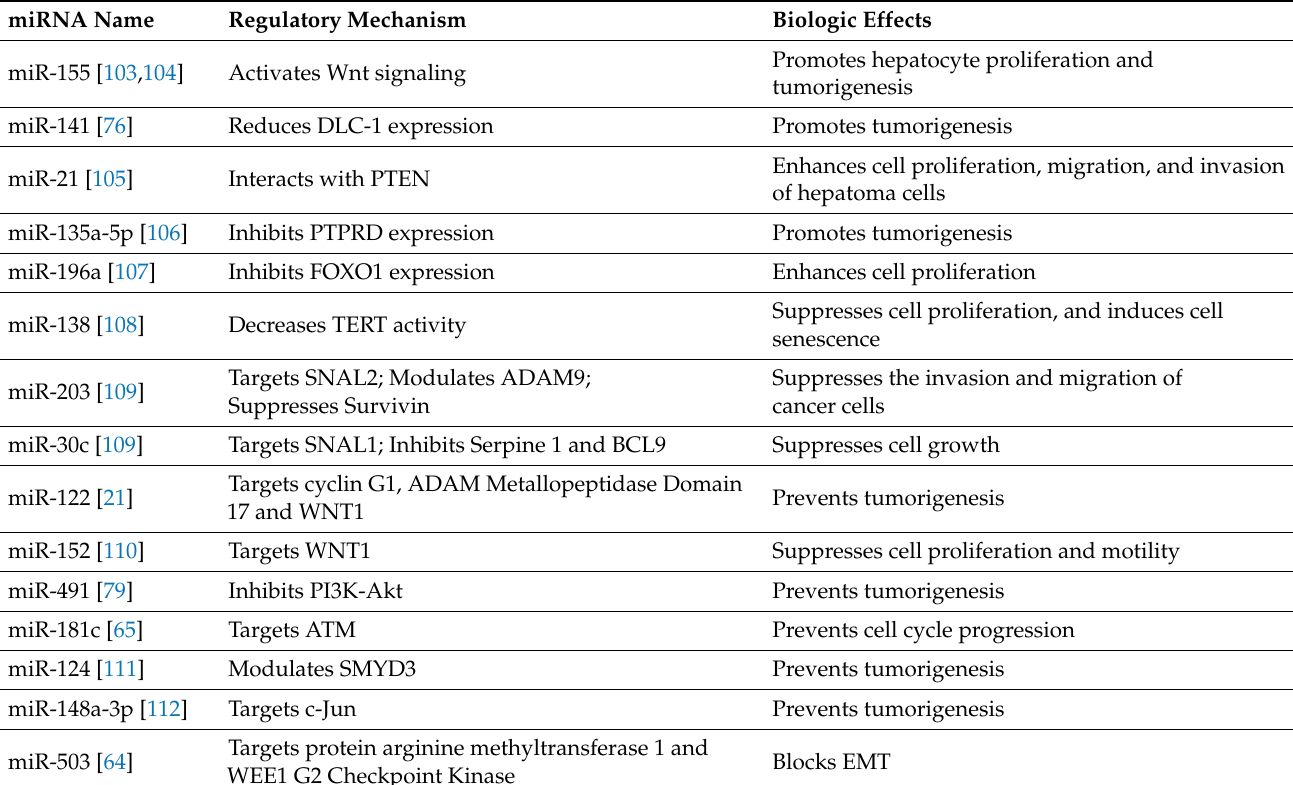
Table 5. miRNAs modulating HCV-related hepatocellular